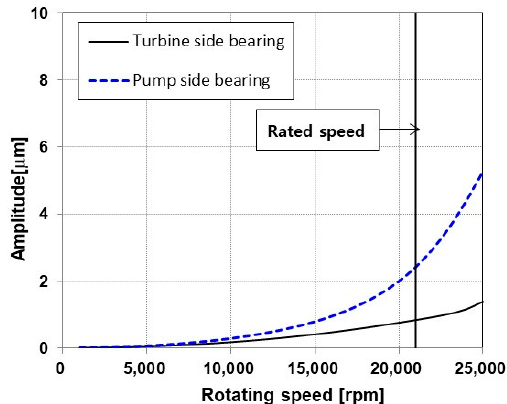
Figure 10. Predicted unbalance response at the two bearings (ISO G2.5).